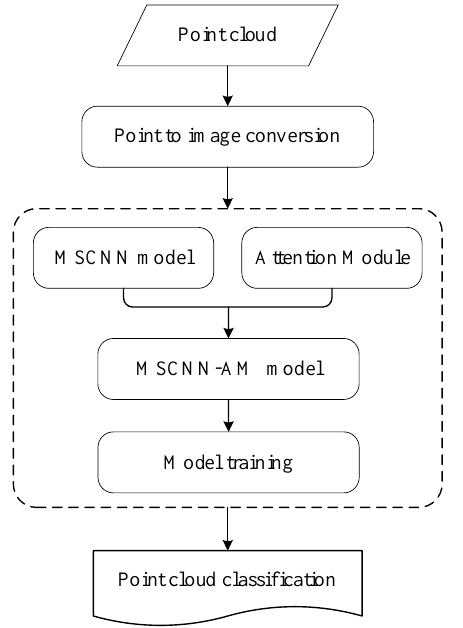
Figure 1. The overall workflow of the proposed point cloud filtering method.